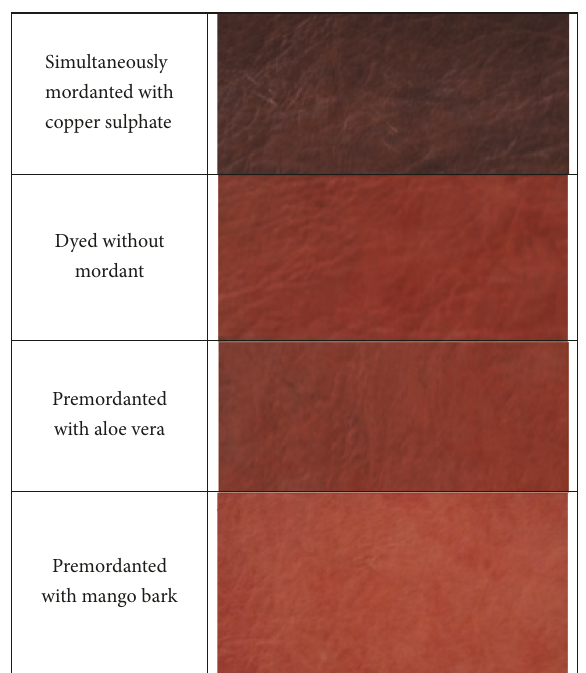
Figure 4: Color produced on leather samples with best color strength (𝐾/𝑆)